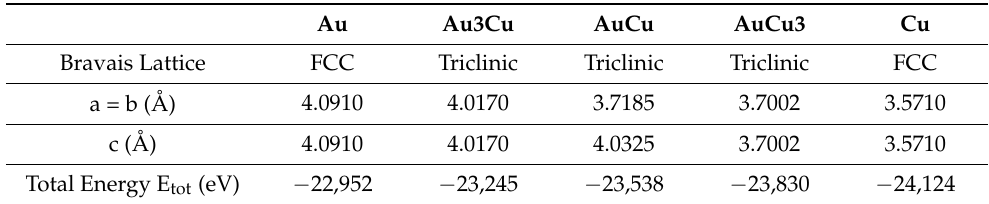
Table 1. Structural properties of Au, Au3Cu, AuCu, AuCu3, and Cu materials were calculated using LDA-PWC.